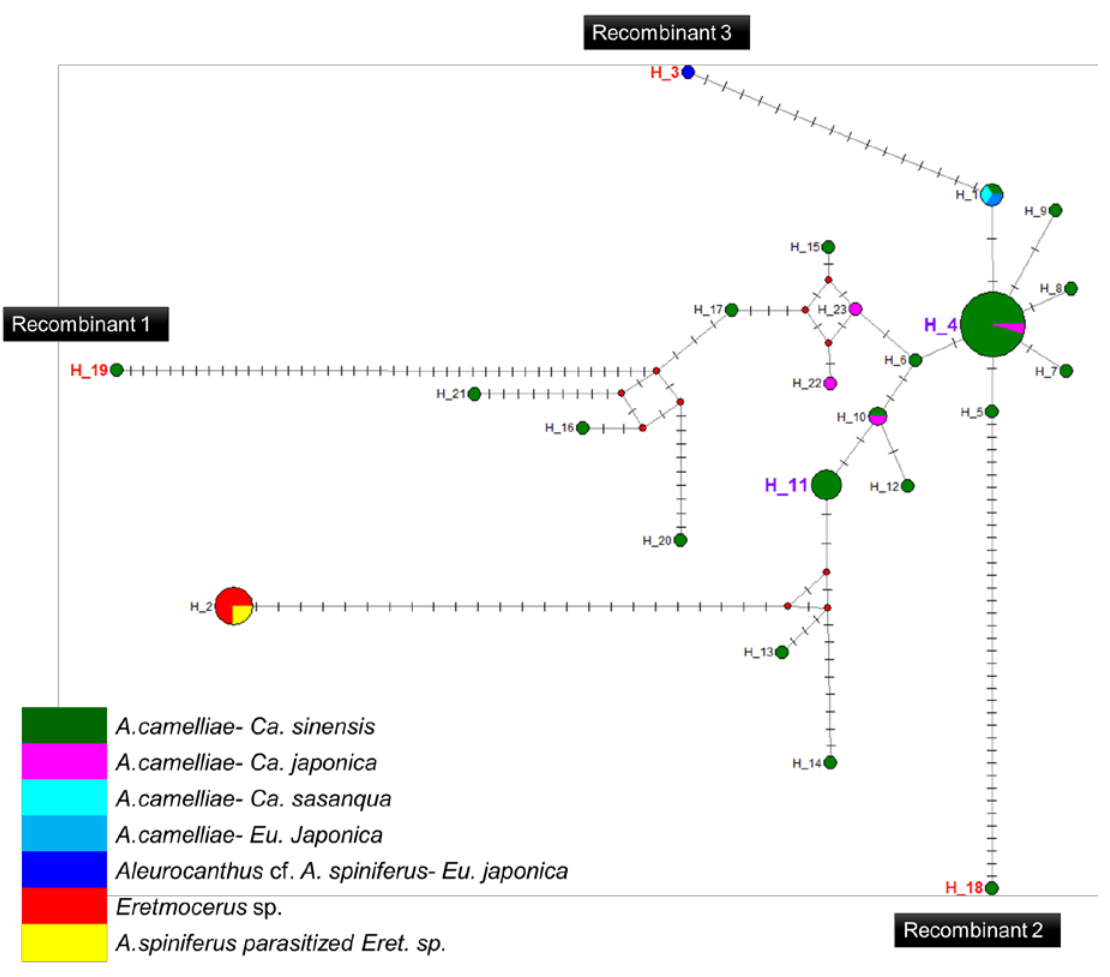
Figure 5. Haplotype network diagram inferred from the 16S rRNA gene of Wolbachia . Red nodes are median vectors. Striped lines indicate the number of nucleotide mutations. Table 6. Intragenic recombination in wAlec by using nine different methods implemented in RDP5 software.